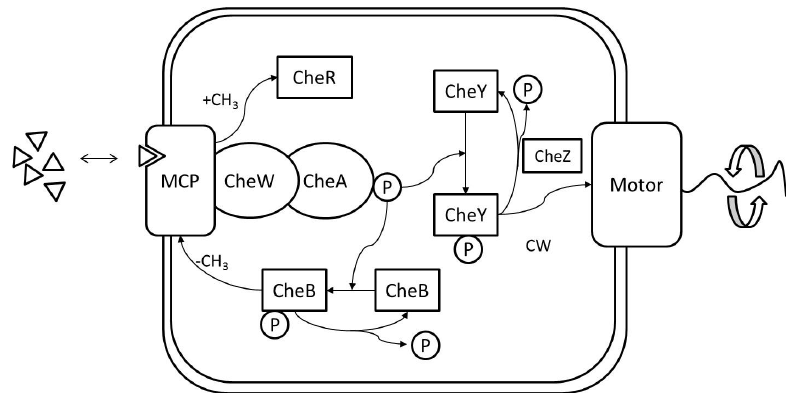
Figure A1. The intracellular signaling pathway of E. coli for chemotaxis. As the chemical molecules (represented as triangular shapes) or chemoattractants bind to the the methyl-accepting chemotaxis proteins (MCP) on the bacterial cell membrane, they activate chemical signaling among Che regulator proteins. P represents phosphoryl group, transferred among signaling components. +CH 3 and − CH 3 represent the methylation and demethylation, respectively, of membrane-bound chemoattractant receptor clusters. Running behavior for bacteria occurs when flagella rotate in a concerted counter-clockwise (CCW) direction; otherwise, the flagellar motor switches to clockwise (CW) rotation, resulting in tumbling behavior.